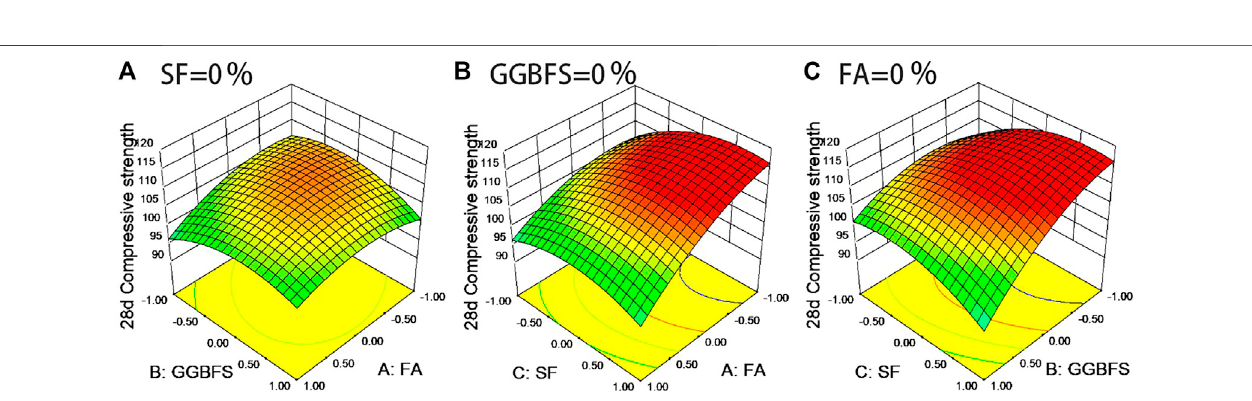
Frontiers in Materials |